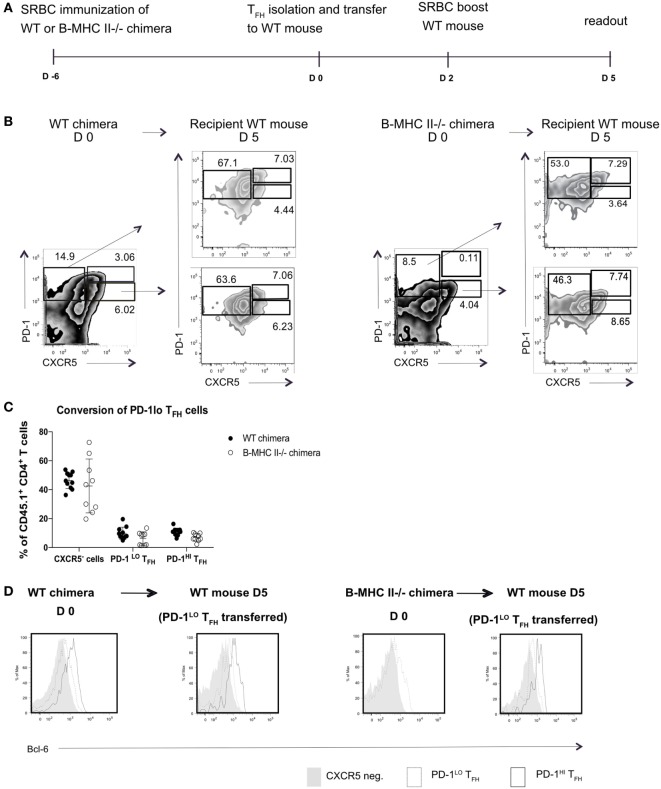
PD-1lo T follicular helper cells (Tfh) can convert to PD-1hi Tfh and upregulate Bcl6 expression. (A) Diagram of experimental set up for Tfh adoptive transfer. CD45.1+ WT or B MHC II−/− chimeras were immunized with SRBC. Six days later, Tfh populations were sorted and transferred to CD45.2+ WT recipients. Forty-eight hours post transfer WT recipients were boosted with SRBC, and final analysis was carried out 3 days later. (B) Flow cytometry plots of T follicular helper (Tfh) and CXCR5− T cell populations isolated from WT chimera or B-MHCII−/− chimera 6 postimmunization with SRBC (day 0) and after the transfer to congenic WT host and challenge with SRBC (day 5). Transferred PD-1lo Tfh-like population is shown in the lower plot and control CXCR5− group in upper plot (recipient mice). (C) Summary of the phenotype acquired by PD-1lo Tfh-like at day 5 post transfer. (D) Bcl-6-expression in PD-1hi (bold black line) and PD-1lo (black line) Tfh and CXCR5− T (gray histogram) cells as gated as in B from WT chimeras or B-MHCII−/− chimeras on day 0 (left) or day 5 post transfer (right). Data are representative of two independent experiments (n = 4–5, WT chimera) or three independent experiments (n = 3–5, B-MHCII−/− chimeras). Each dot represents a single mouse.